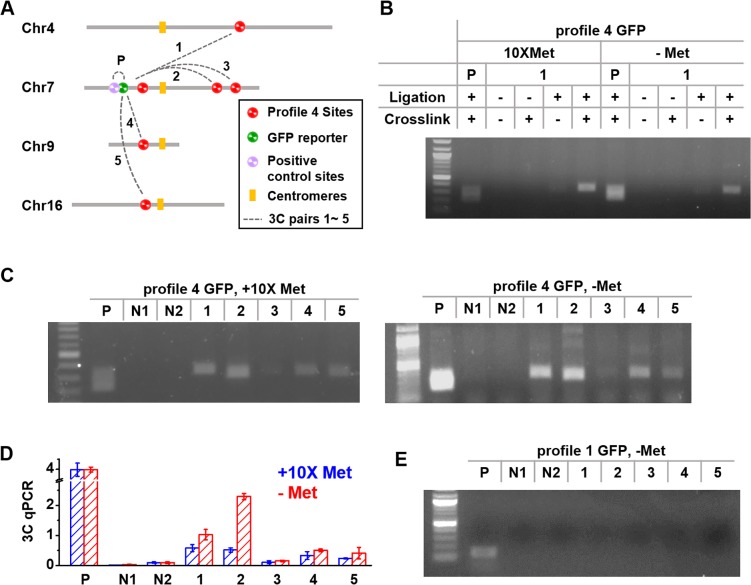
Long-distance interaction between profile 4 sites.A) 3C scheme to detect interactions between the GFP reporter (inserted into CWC23) and other profile 4 sites (1: ADK1, 2: GTO1, 3: XKS1, 4: SER33, 5: PDR12). B) 3C assay between the GFP reporter and ADK1 (interaction #1) under both +/–methionine conditions in the presence of absence of crosslinking and/or ligation. P: positive control (3C between the GFP reporter and a cis region ~13kb away). The 3C product is only visible with ligation and crosslinking. C) 3C assay between the GFP reporter and five profile 4 sites (see A) under both +/–methionine conditions. Besides the same positive control (P), we also included two negative controls (N1 and N2; see text for detailed explanation). D) Quantification of the 3C signals in C using qPCR. The 3C signals of interaction 1, 2, 4, and 5 are increased after–Met induction (p-values are 0.0016, 0.0057, 0.049, and 0.0001), while that of the positive control remains constant. E) 3C assay between profile 4 sites 1–5 and the GFP reporter that is translocated to Chr15. The signals in 1–5 are no longer visible.